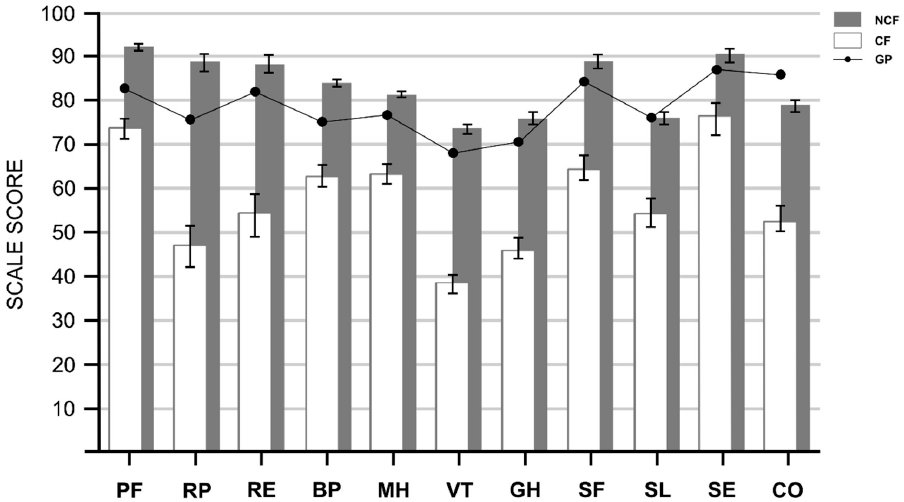
Figure 2. Mean total scores for HRQOL domains for CCS with and without chronic fatigue. Mean Health Related Quality of Life (HRQOL) subscale scores of Childhood Cancer Survivors (CCS) with chronic fatigue (CF) and CCS without chronic fatigue (NCF). Error bars show 95% Confidence Interval. Black line represents mean subscale scores of the General Population (GP) [31,33]. Subscales of SF-36: PF = Physical Functioning; RP = Role physical; RE = Role Emotional; BP = Bodily Pain; MH = Mental Health; VT = Vitality; GH = General Health. Subscales of TAAQOL: SL = Sleep; SE = Sexuality; CO = Cognitive Functioning.